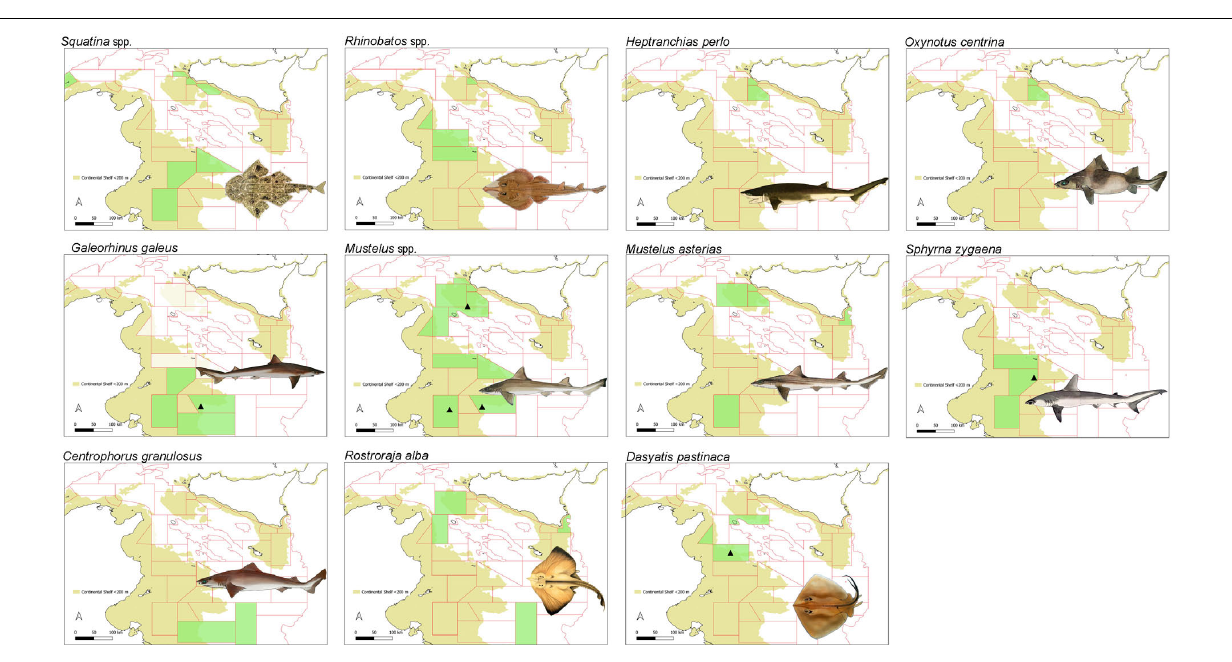
abundance data on elasmobranchs, collected during surveys and fisheries monitoring programs, are not very informative of the current status of populations. Survey data for instance, gathered during the last 30 years, usually show a low but rather stable species abundance without clear trends (Ragonese et al.,